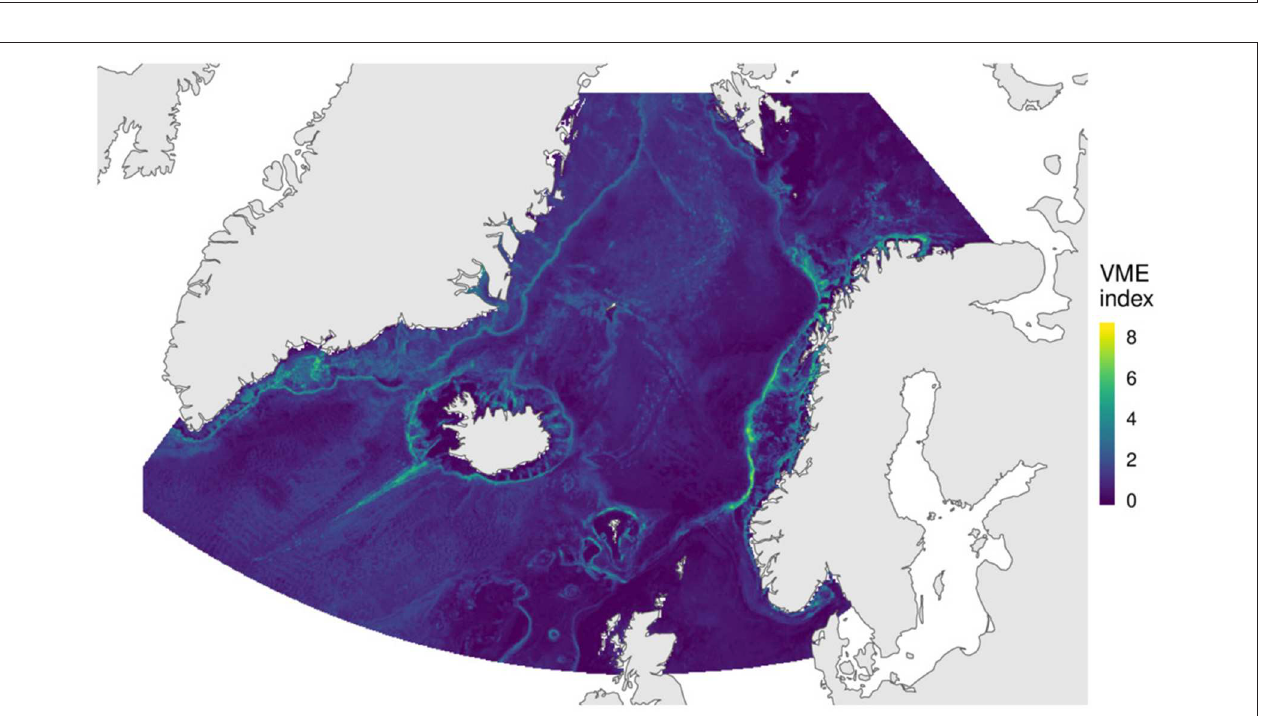
FIGURE 7 | VME index combining indicator scores by Morato et al. (2018), and abundance scores from the species distribution models of 44 indicator taxa.